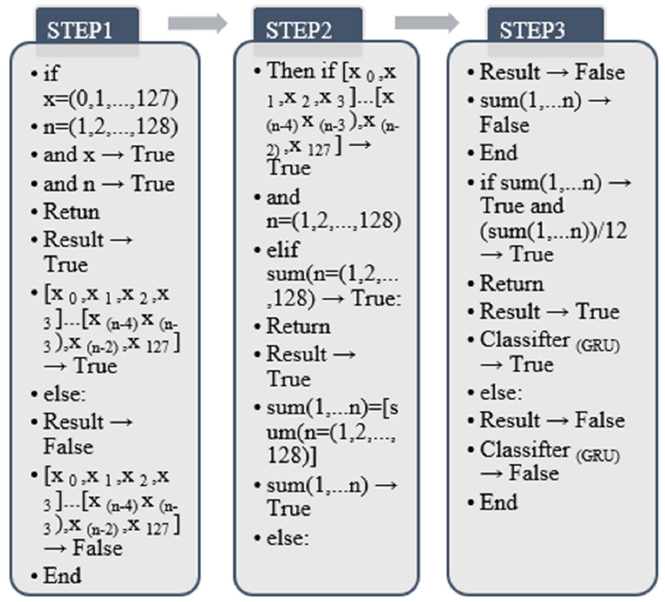
Figure 17. GPU algorithm output graph.